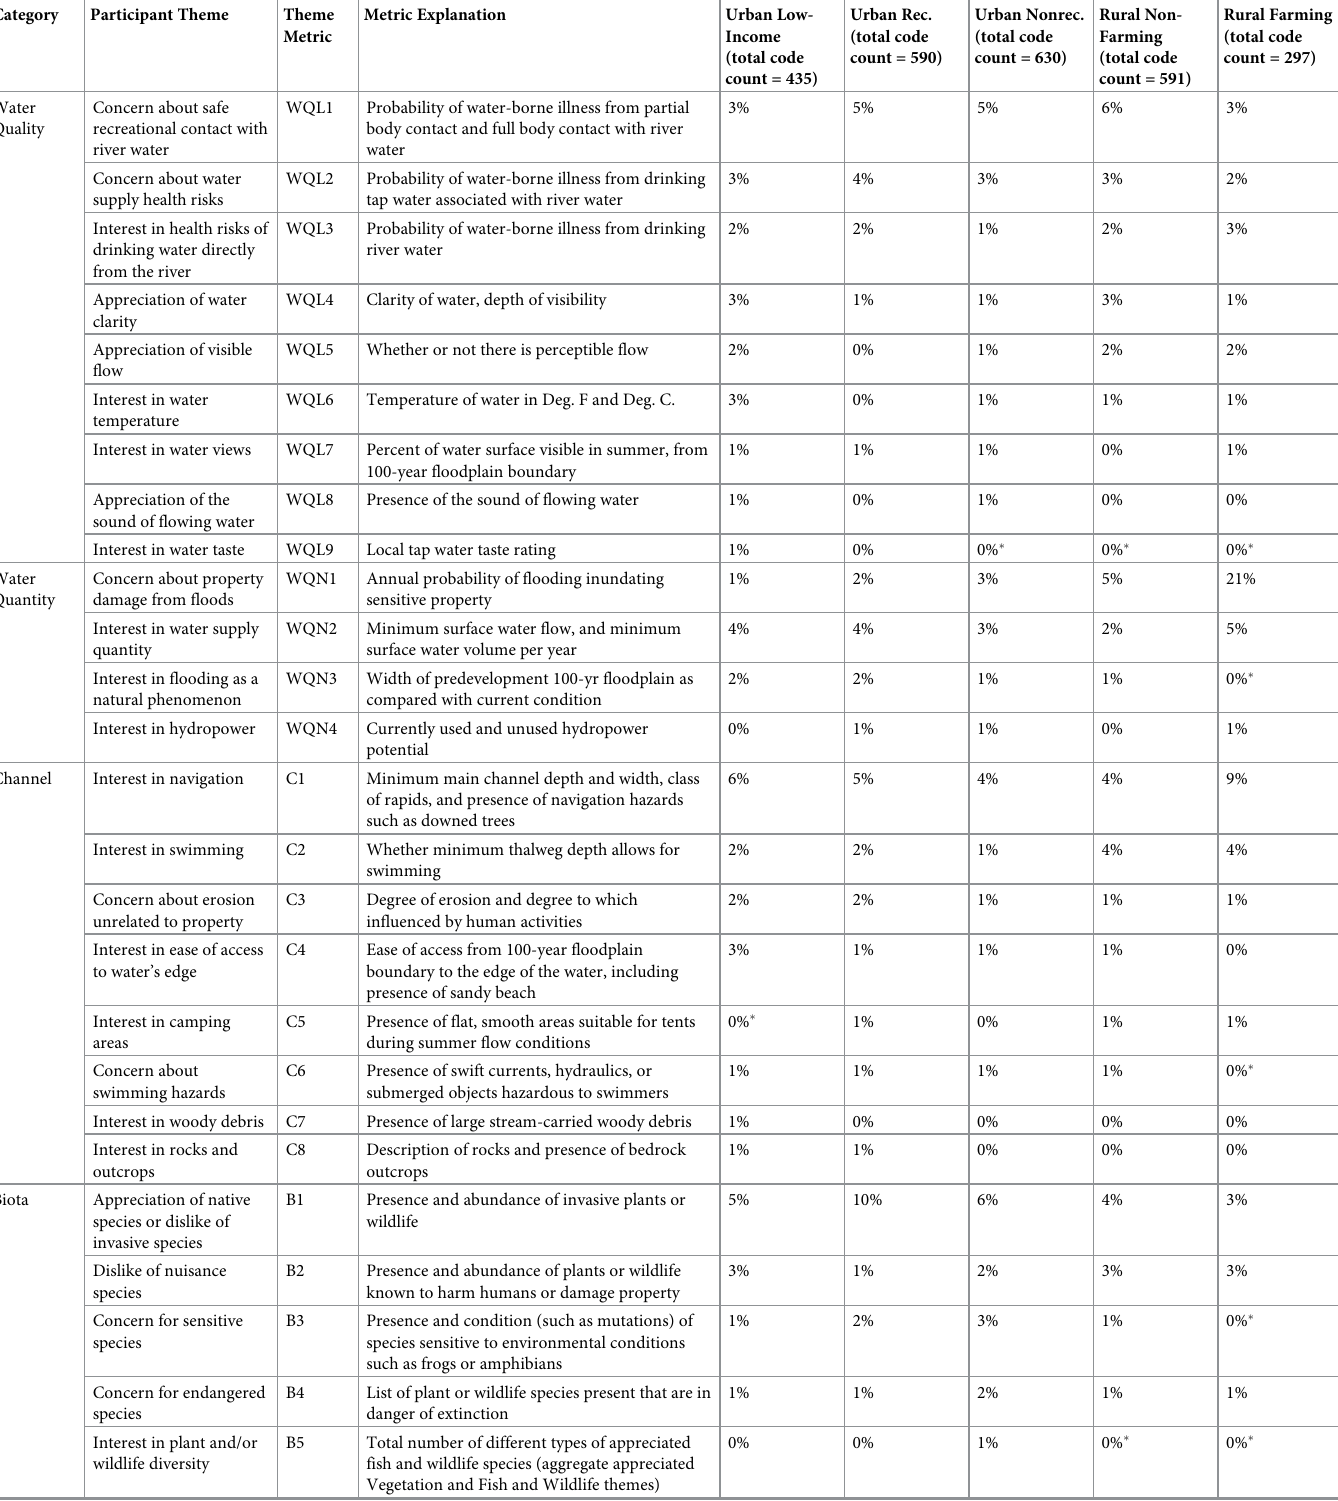
Table 3. Themes, metrics, and segment relative frequencies for river final ecosystem goods and services, and human features. Each segment sums to